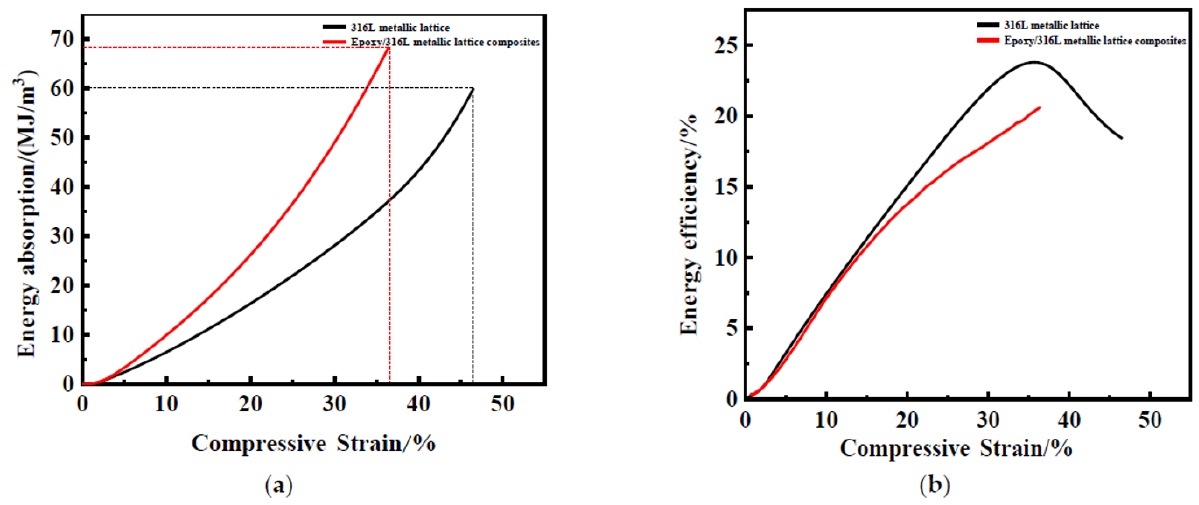
Figure 8. ( a ) Energy absorption curve of the 316L metallic lattice structure and the epoxy/316L metallic lattice composites. ( b ) The curve of energy absorption